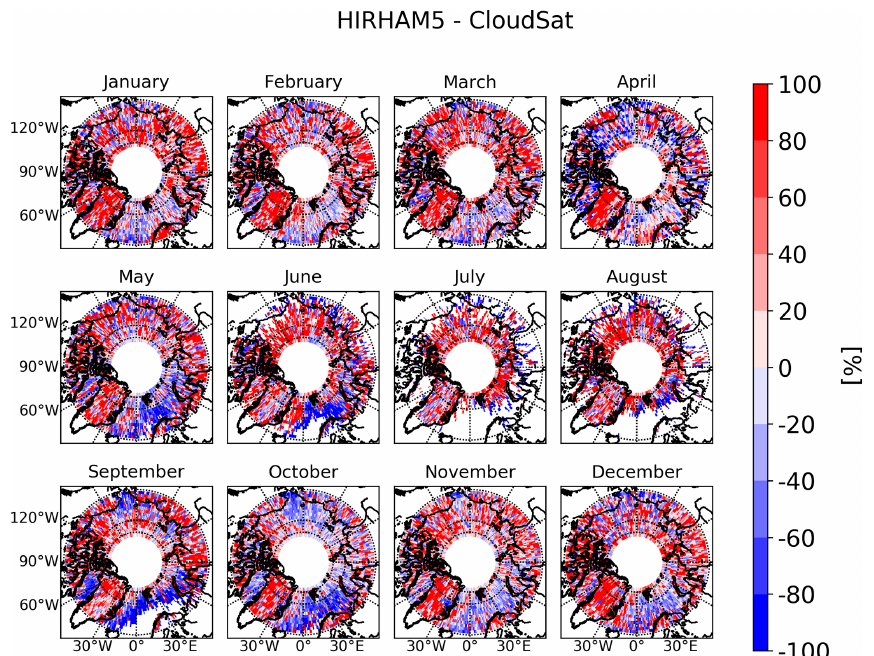
Figure A4. Difference of the monthly mean snowfall rates (%) of HIRHAM5 and CloudSat. Here with red colors HIRHAM5 shows higher rates, whereas with blue colors CloudSat observes higher rates. Percentages are calculated related to CloudSat observations.